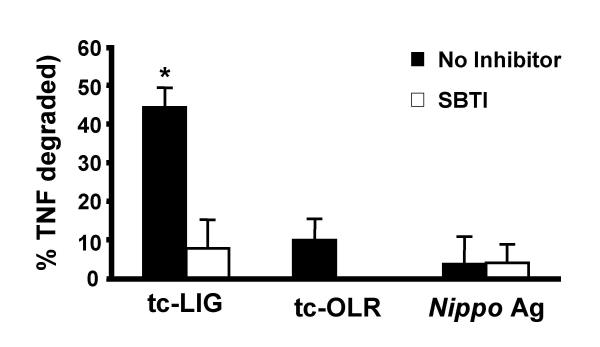
Effect of SBTI on the proteolytic activity in supernatants of tc-LIG-stimulated mast cells. Supernatants from PMC stimulated by tc-LIG, tc-OLR, and Ag for 8 hr were incubated with or without SBTI (1 mg/mL) before 150 pg/mL of TNF was added and % degradation calculated. Values indicate proteolytic activity after the subtraction of spontaneous release (17 % ± 7). Star indicates statistically significant difference from spontaneous (p < 0.05, n = 4–5). (Mean ± SEM).